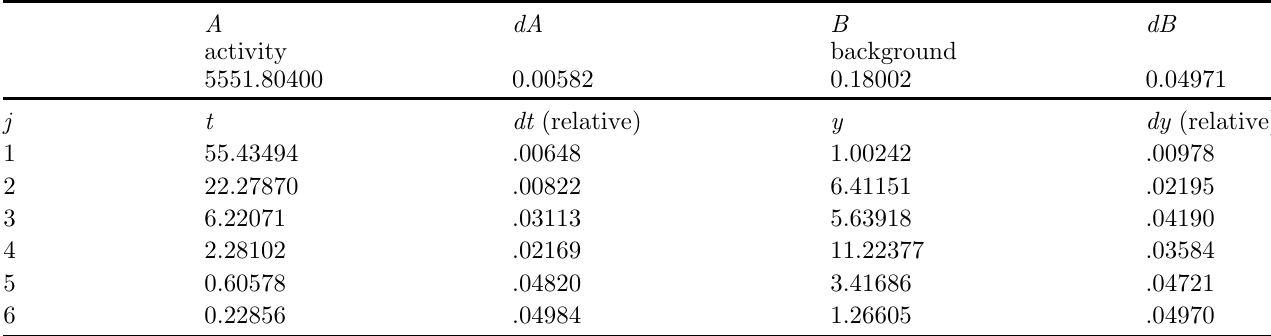
Table A4. Temporal DN parameters obtained in the result of the steps 1 – 3 using set#1 as a priori data (group yields are obtained relatively to the yield of the fi rst group).